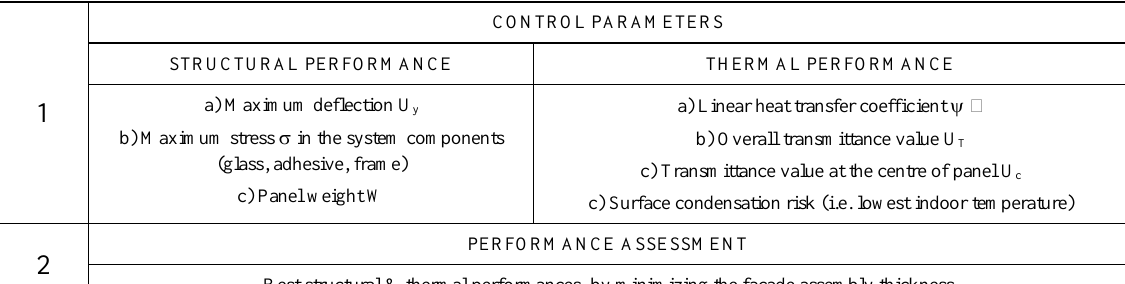
Table 1: Control parameters and input variables for the parametric